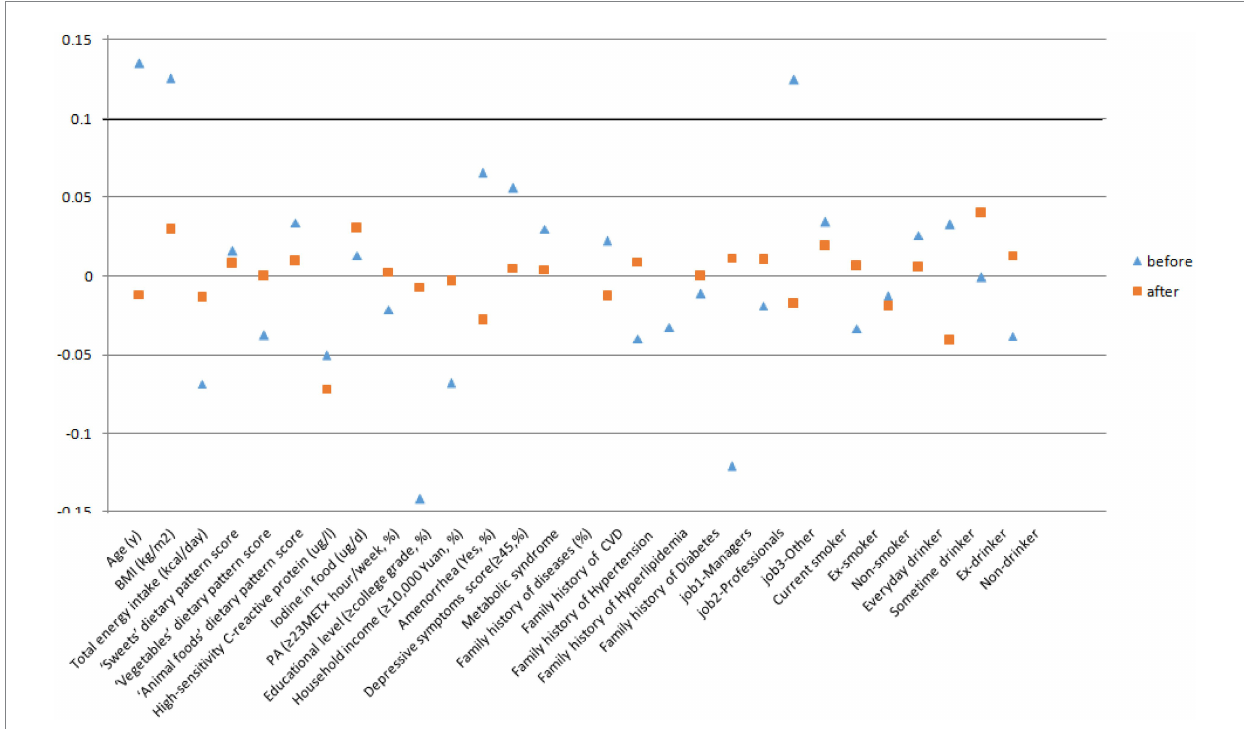
FIGURE 2 Standardized mean differences of covariances before and after propensity score